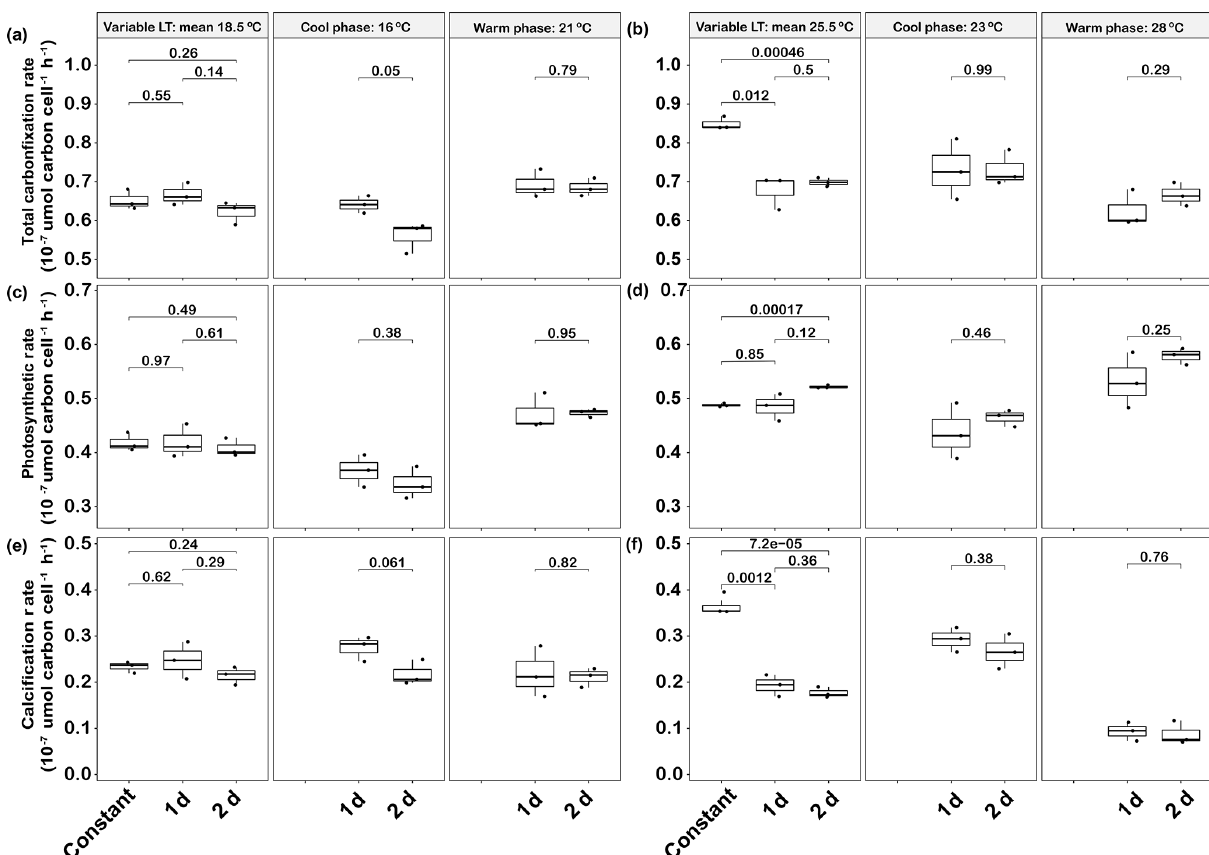
Figure 5. Responses of Emiliania huxleyi photosynthetic carbon fixation and calcification at constant temperatures and during the warm and cool phases of two thermal variation frequencies (1d and 2d), including total carbon fixation (photosynthesis + calcification) at low (a) and high (b) temperatures, photosynthetic carbon fixation at low (c) and high (d) temperatures, and calcification rates at low (e) and high (f) temperatures. LT: low temperature; HT: high temperature. The thick black line in the boxplots represents median values for each experimental treatment; the whiskers on the boxplots indicate 1.5 × interquartile range. Listed p values with their respective brackets denote the statistical significance between two